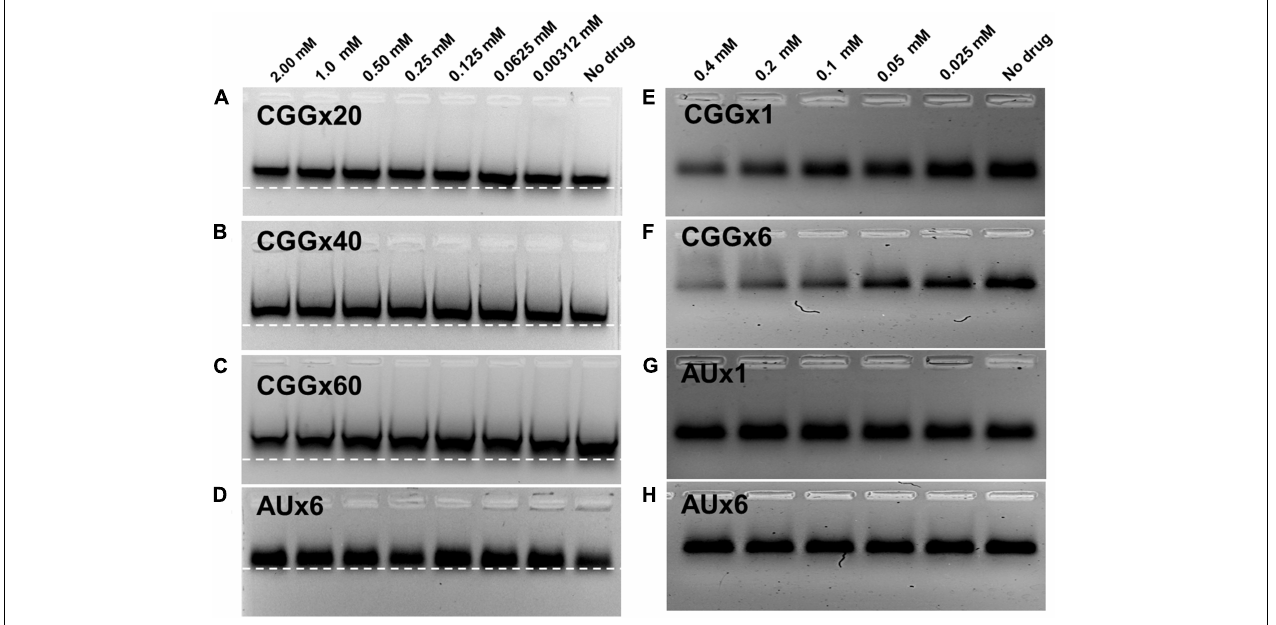
FIGURE 5 | Electrophoretic mobility shift (EMSA), and PCR inhibition assay. EMSA plot shows significant retardation in mobility of CGG repeats RNAs with the increasing concentration of Curcumin. (A) r(CGGx20) (B) r(CGGx40) and (C) r(CGGx60) RNA. In contrast no significant retardation was detected with (D) r(AU)6 × duplex RNA. PCR inhibition assay of CGG DNA templates were performed with Curcumin as a function of concentration; decrease in the PCR band intensity suggests the binding of Curcumin with CGG Repeat (E) (CGGx1) and (F) (CGGx6). In contrast, no significant inhibition was observed in the PCR band intensity of AU duplex DNA templates G) (AUx1) and (H)